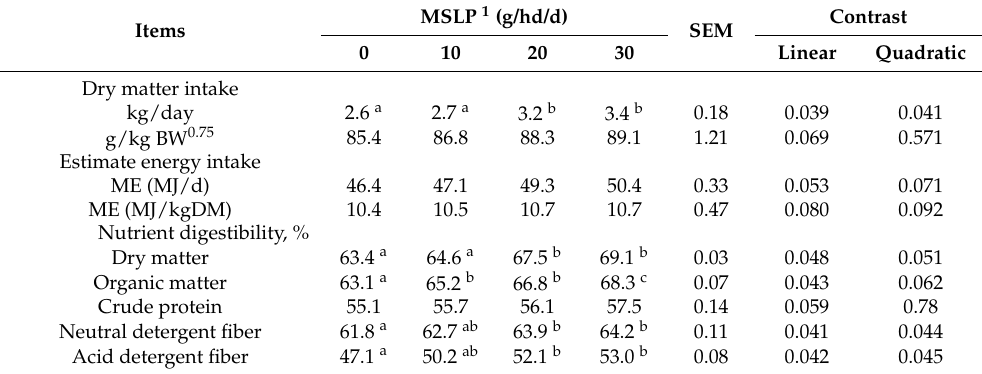
Table 2. Effect of Mitragyna speciosa Korth leaf pellet supplementation on voluntary feed intake and nutrient digestibility in Thai native beef